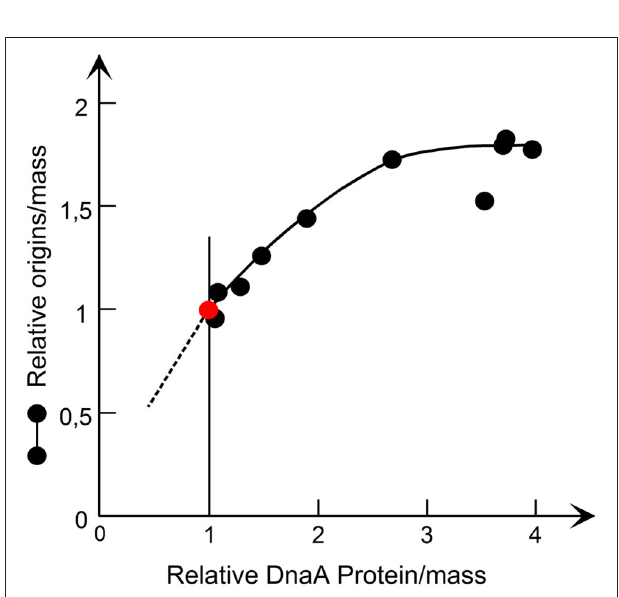
FIGURE 4 | The origin/mass responds to an increase in DnaA protein. The DnaA protein was synthesized from a lacP controlled dnaA gene and origins/mass was determined by flow cytometry. The data are redrawn from Figure 4 in Atlung and Hansen (1993, Copyright, American Society for